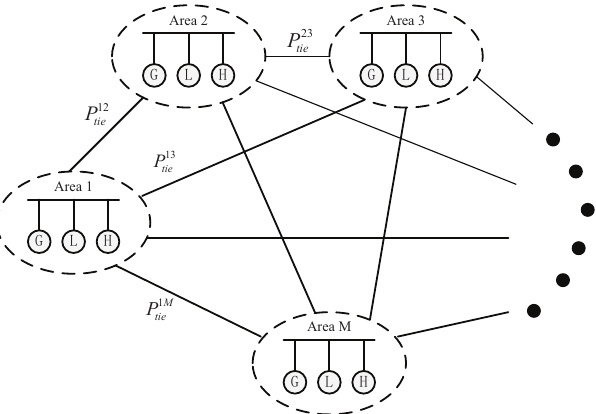
Figure 1. Schematic of a multi-area interconnected power system with a hybrid energy storage system (HESS), where “G” represents the generator system, “L” represents the load, and “H” represents the